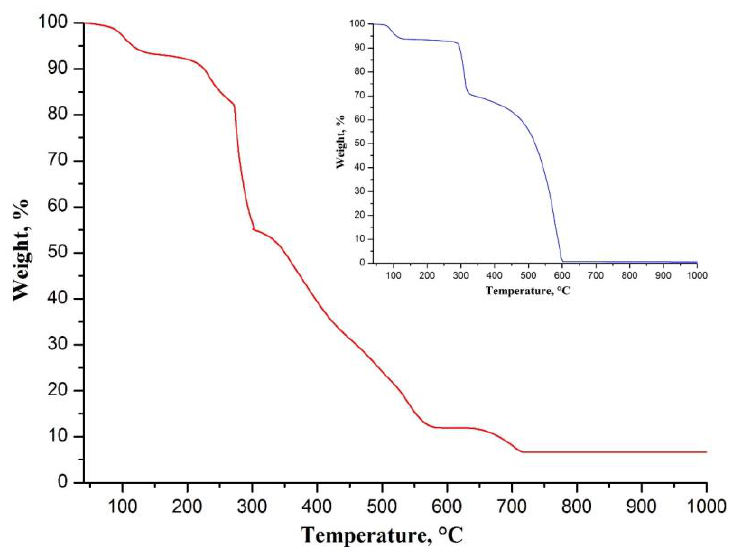
Figure 1. TG curve of electrospun CaAA/PAN fibers. The insert shows TG curve of electrospun PAN fibers.